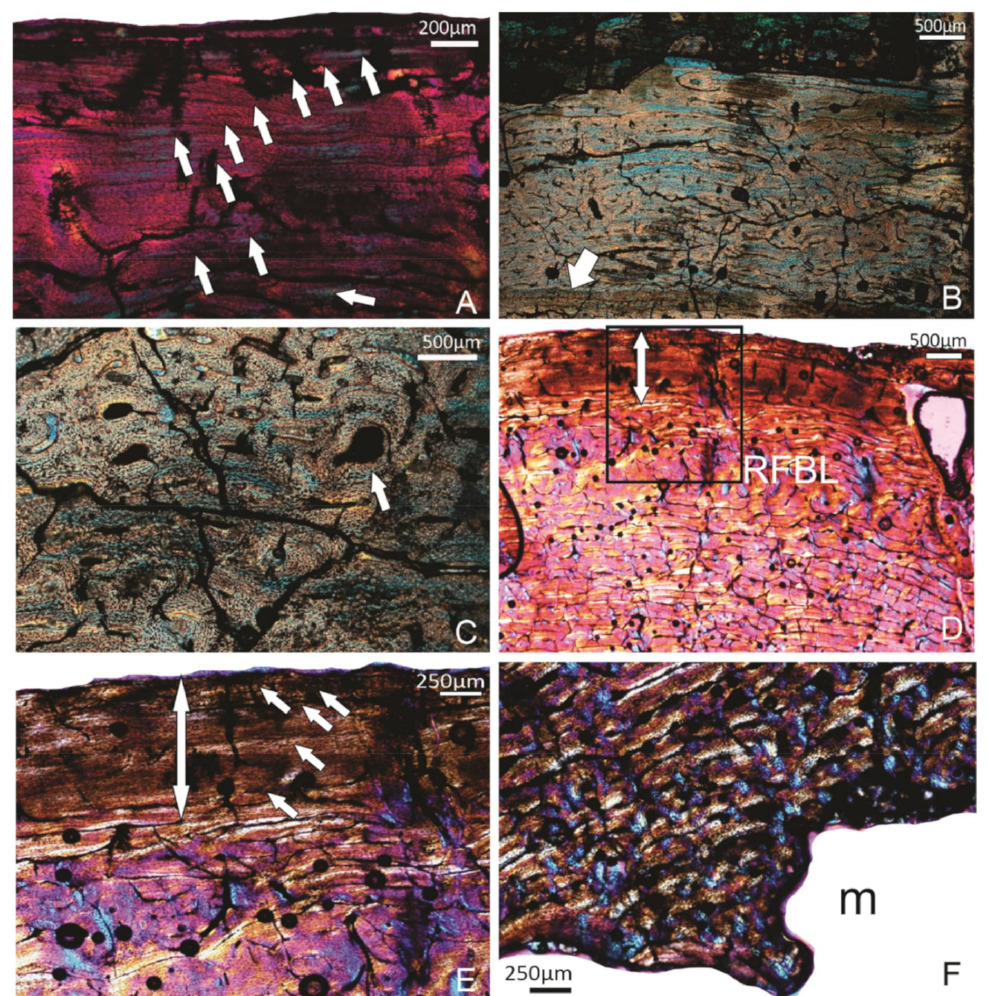
Figure 5. ( A – C ) Specimen FU2756; tibiotarsus. ( A ) The OCL with at least 10 LAGs (arrows). ( B ) A deeper part of the compacta showing the laminar organised FBL bone tissue, and a single annulus with a LAG (arrow). ( C ) FBL bone tissue with more longitudinal and reticular organised vascular canals. Arrows point to the lamellar bone tissue in the process of being deposited around an enlarged cavity. ( D – F ) Specimen SAM P.25017, tibiotarsus. ( D ) A general view of the compacta. The double-headed arrow indicates the OCL. RFBL indicates the band of reticular organised FBL bone tissue that precedes the OCL. ( E ) Higher magnification of the framed region of (D). The OCL with 5 LAGs (arrows). ( F ) The innermost part of the compacta being actively resorbed. m, medullary